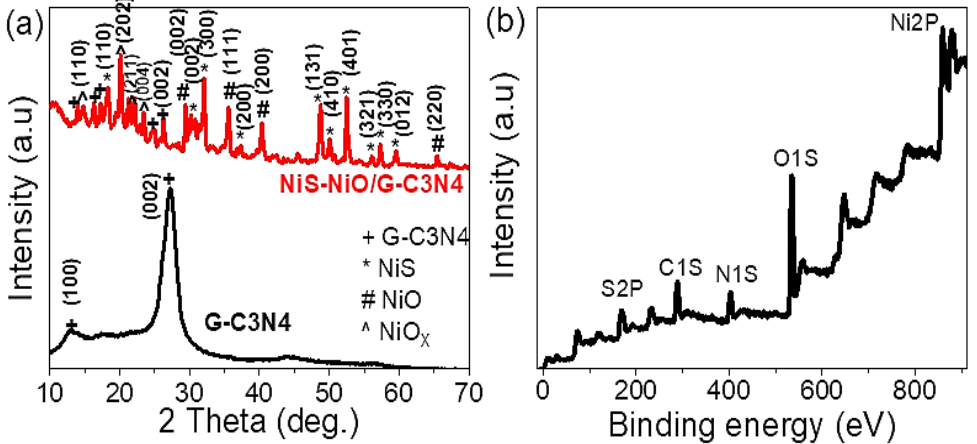
Figure 2. ( a ) XRD and ( b ) XPS for NiS-NiO/G-C3N4 composite.